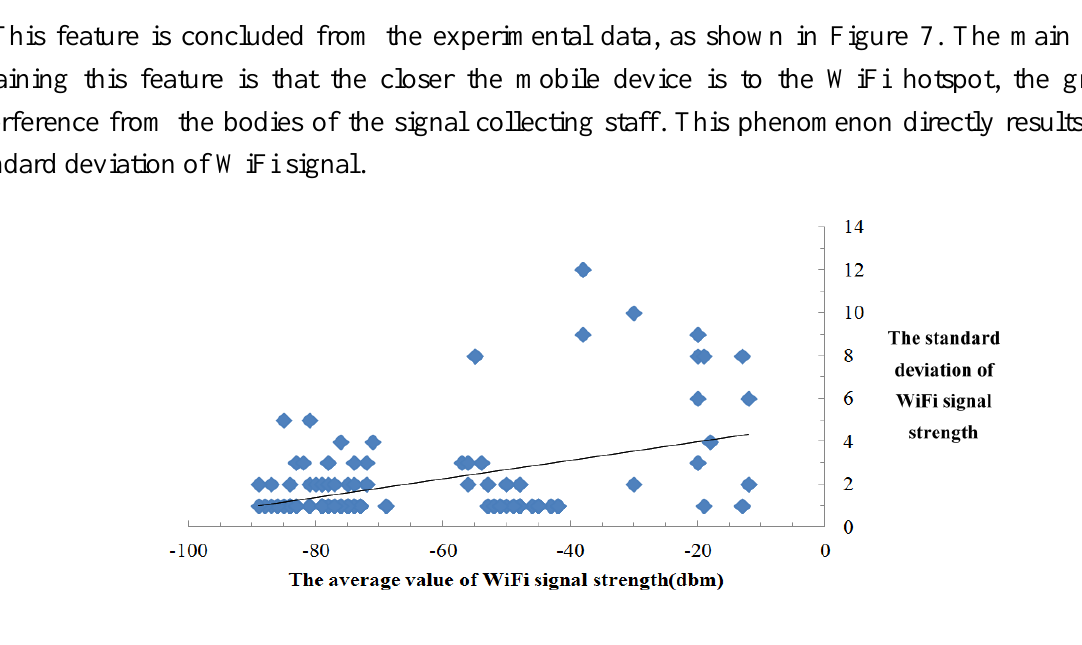
Figure 7. Feature of WiFi